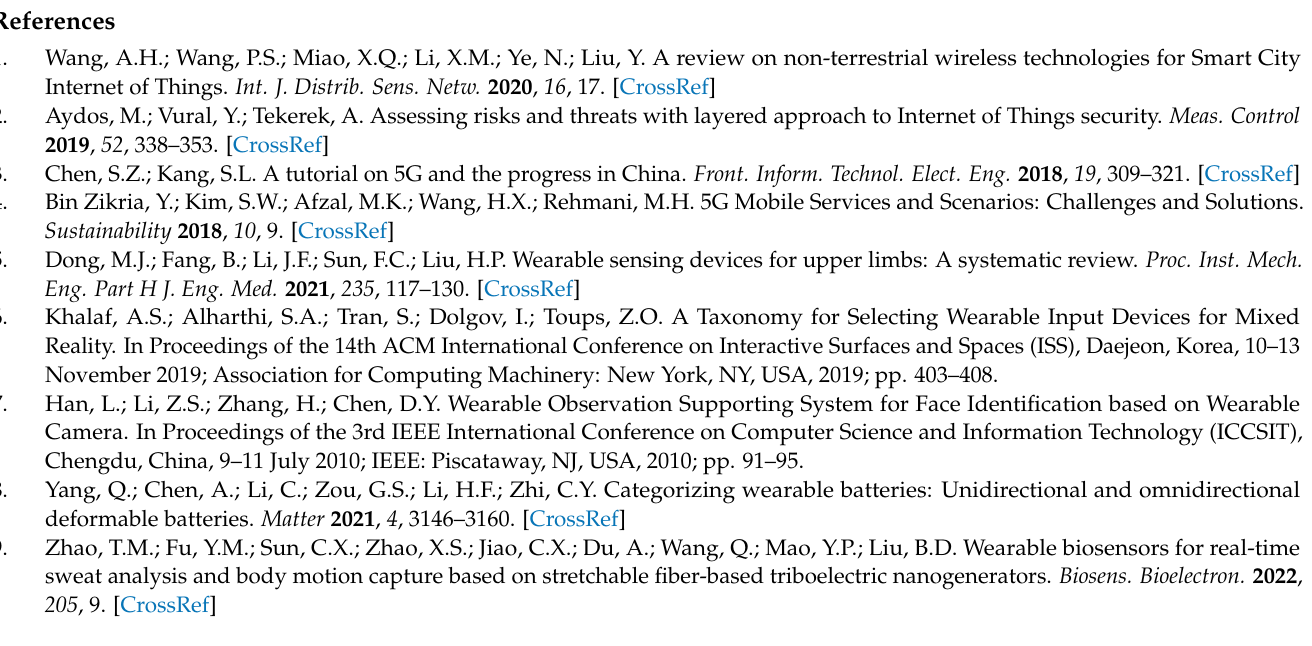
PTFE on the trigger.; Figure S2: Different relative humidity test and voltage of sweat simulation.; Figure S3: The applied force of durability test.; Figure S4: The relationship of voltage with trigger gravity; Figure S5: Relationship between voltage and rings of different people shooting with different guns at different distances.; Figure S6: The voltage of different trigger frequency. Video S1: SPTENG lights LED; Video S2: The signal transmission; Video S3: Multi-point control; Video S4: The Man– machine interaction